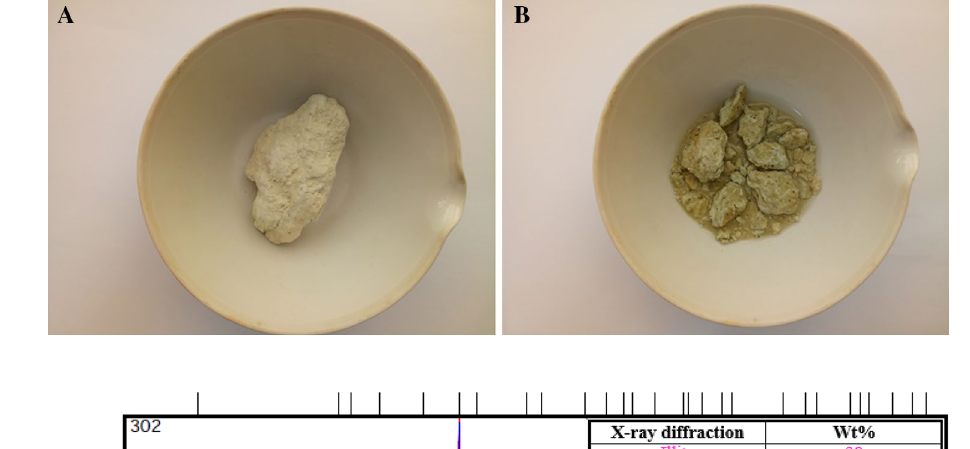
Fig. 3 XRD pattern of shale